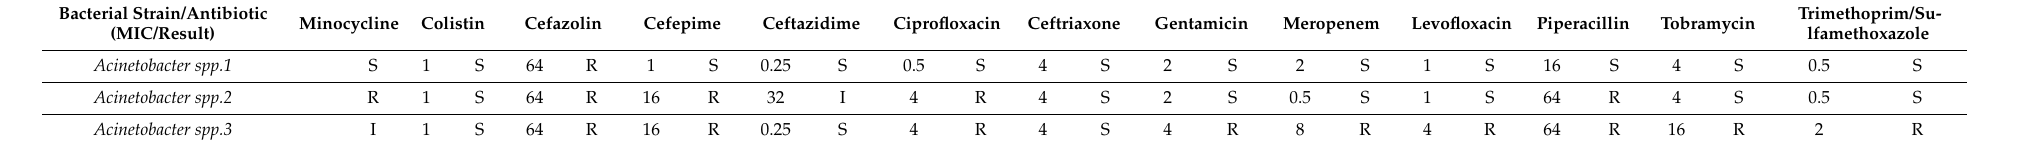
Table 10. MICs (mg/L) of antimicrobials for Acinetobacter spp. isolates. Bacterial Strain/Antibiotic (MIC/Result)